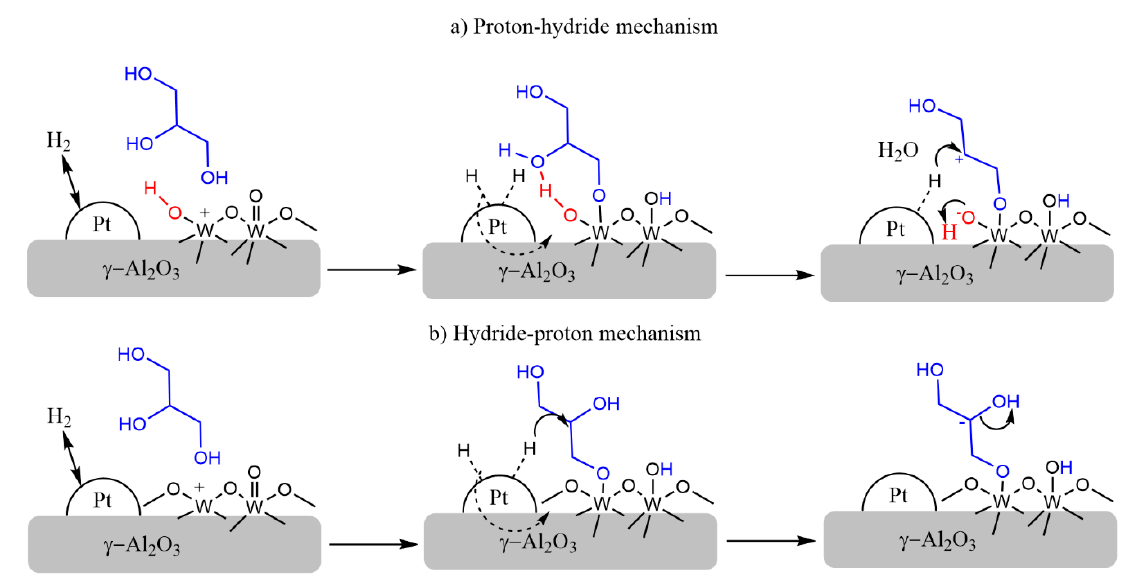
Scheme 1. Model structures of the transition states for the proton–hydride mechanism ( a ) and for the hydride–proton mechanism ( b ).